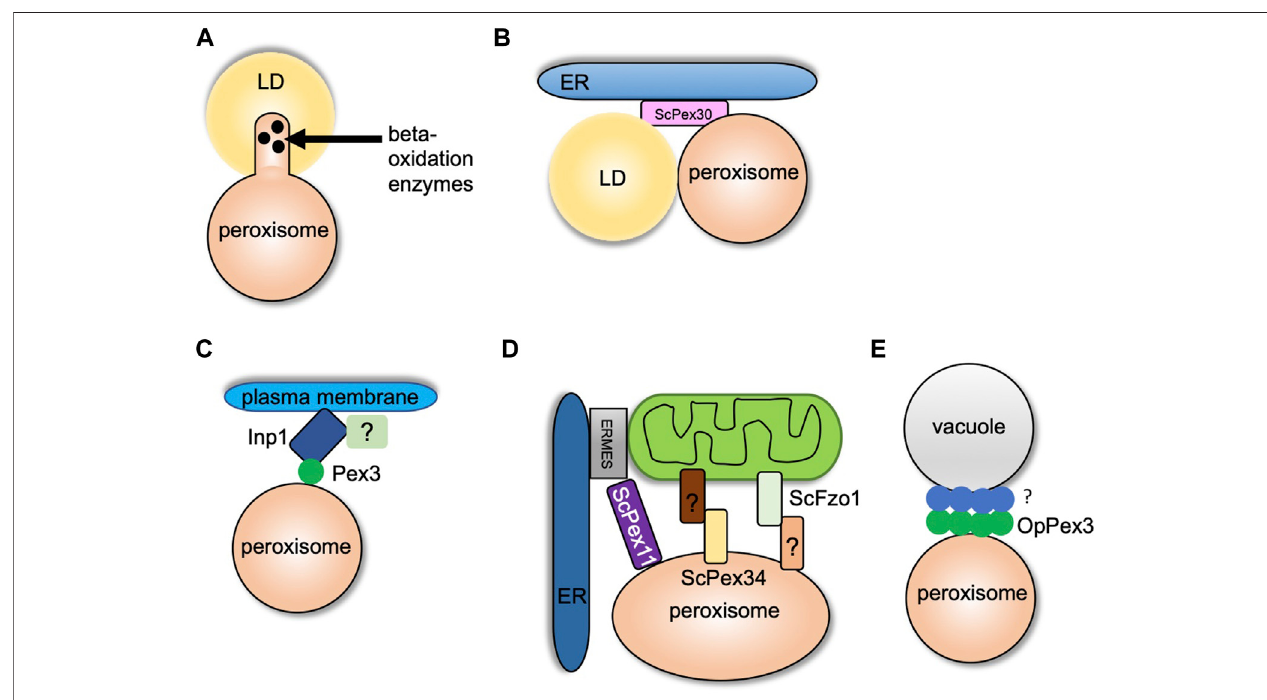
FIGURE2| Peroxisomecontactsitesinyeasts. (A) and (B) indicateperoxisome – LDcontactsites. (A) Formationofpexopodiaenrichedinbeta-oxidationenzymes into the core of LDs in peroxisome-proliferating growth conditions. (B) LDs and peroxisomes interact at the ScPex30 ER subdomains. (C) Peroxisome – plasma membranecontactsite.Inp1bindstotheplasmamembraneatsitesenrichedinPI(4,5)P2withanotherpossiblebindingpartner.Inp1tethersperoxisometotheplasma membrane by binding Pex3 localized on the peroxisomal membrane. (D) Peroxisome – mitochondria contact sites. Pex11 binds Mdm34 of the ERMEScomplex at the ER – mitochondria contact sites. Fzo1 on mitochondrial membrane contacts an unknown binding partner on peroxisomes, and Pex34 on peroxisomal membrane binds an unknown binding partner on the mitochondria. (E) Peroxisome – vacuole contact sites. OpPex3 accumulates at the peroxisome – vacuole contact sites in peroxisome-proliferating conditions or when overexpressed. The OpPex3 binding partner on the vacuolar membrane is unknown.